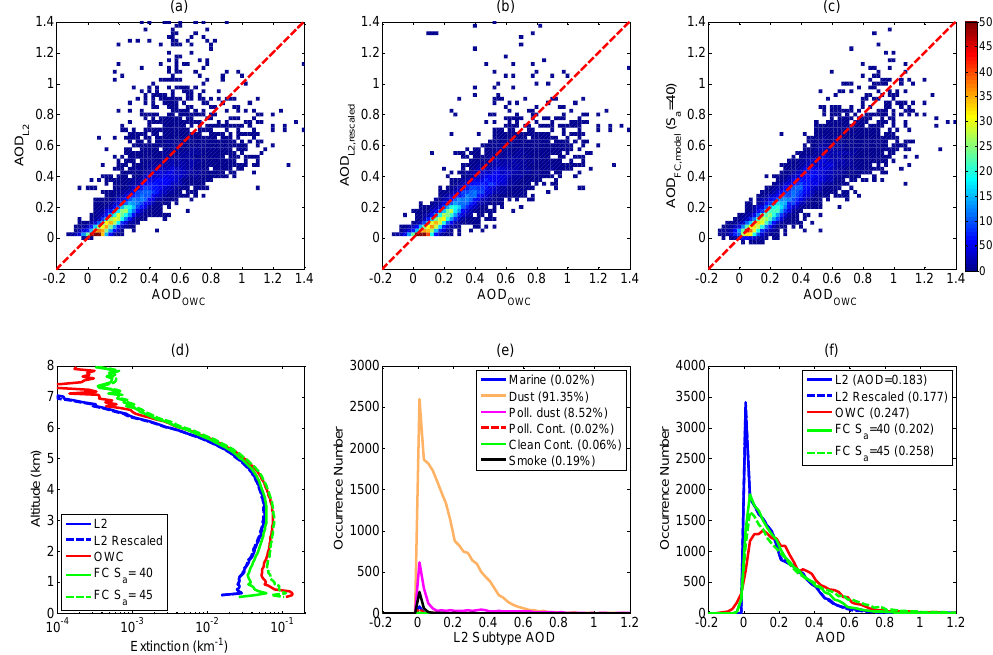
Figure 11. Analysis results for the dust transport region as indicated by the red box in Fig. 6. The top row shows 2-D distributions of (a) AOD L2 vs. AOD OWC , (b) AOD L2,res vs. AOD OWC , and (c) AOD FC, mod vs. AOD OWC for S a =40sr. The bottom row shows (d) mean extinction profiles and histograms of occurrence number, (e) L2 AOD of different aerosol types, and (f) AOD retrieved using different retrieval methods. The bin size for AOD is